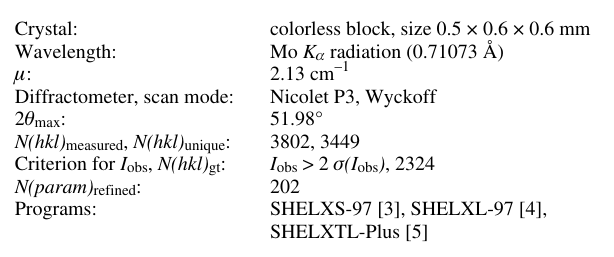
Table 1. Data collection and handling.